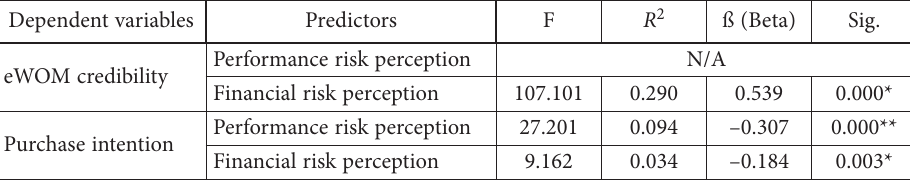
Table 4. Regression analysis results for promotion-focused consumers Dependent variables